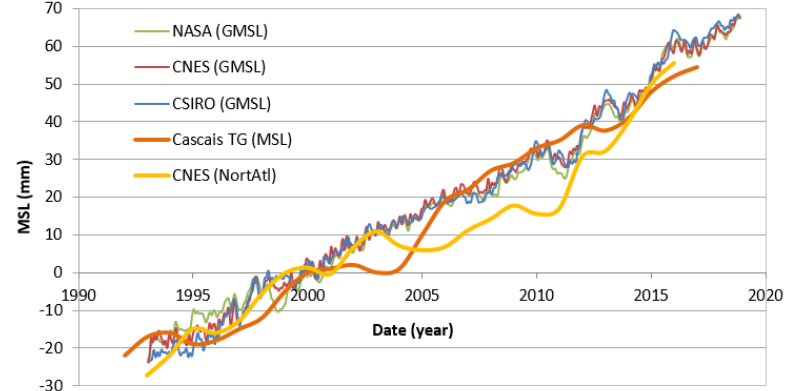
Figure 3. Satellite altimetry GMSL anomalies from three international data centers, NASA, CNES (global and North Atlantic region), and CSIRO, superimposed to the Cascais MSL trend adjusted to 2000 reference.